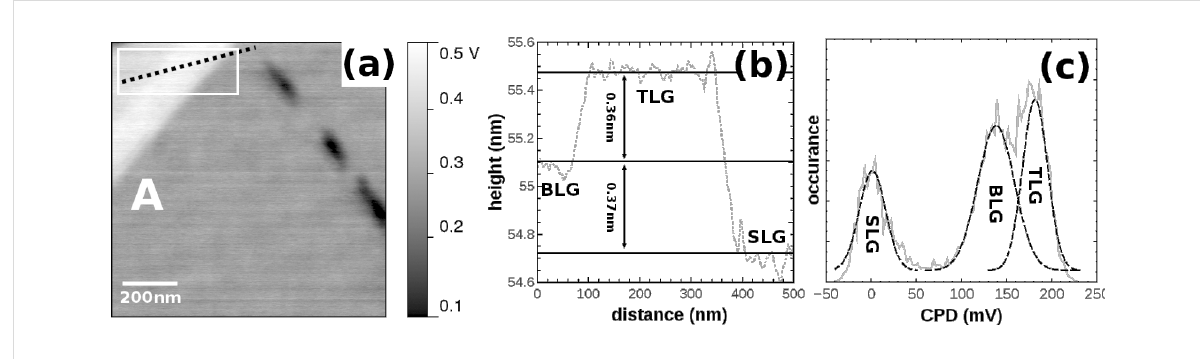
Figure 5: (a) LCPD image of the folding marked by A in Figure 4. (b) The profile taken in the corresponding NC-AFM image reveals the height of BLG and TLG in agreement with the interlayer distance (marked by horizontal full lines) found for graphite stacking. (c) From the CPD histogram performed in the square marked in Figure 5a, the LCPD between SLG and BLG (137 ± 40 meV) and BLG and TLG (43 ± 27 meV) can be identified by normal distributions, in which the error is one standard deviation ( σ ).